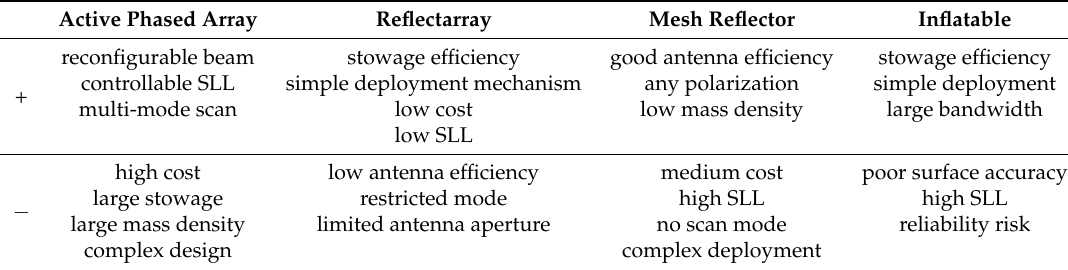
Table 2. Advantages and disadvantages of potential high gain deployable antenna technology concepts for a 150-kg class microsat